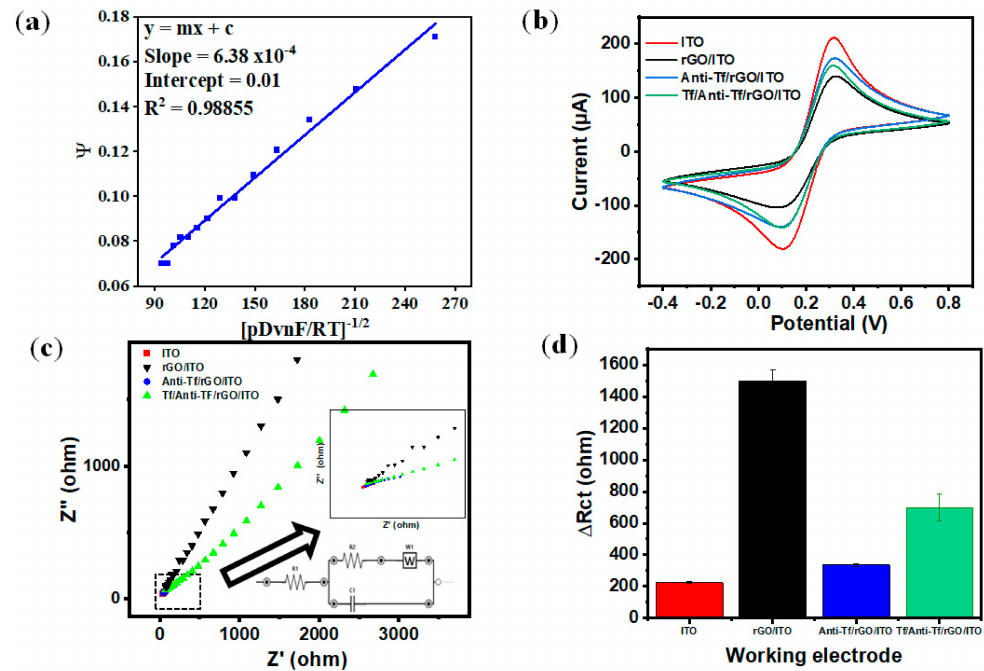
Figure 3. ( a ) Plot of Ψ vs. square root of Π D ν nF/RT for rGO/ITO; ( b ) CV of all modified electrodes; ( c ) EIS response of all modified surfaces with the equivalent circuit model; inset shows a zoomed − in view of all responses; ( d ) comparative histogram of the Rct values of all electrode surfaces, highlighting the increased resistance of the final surface caused by insulation on the electrode